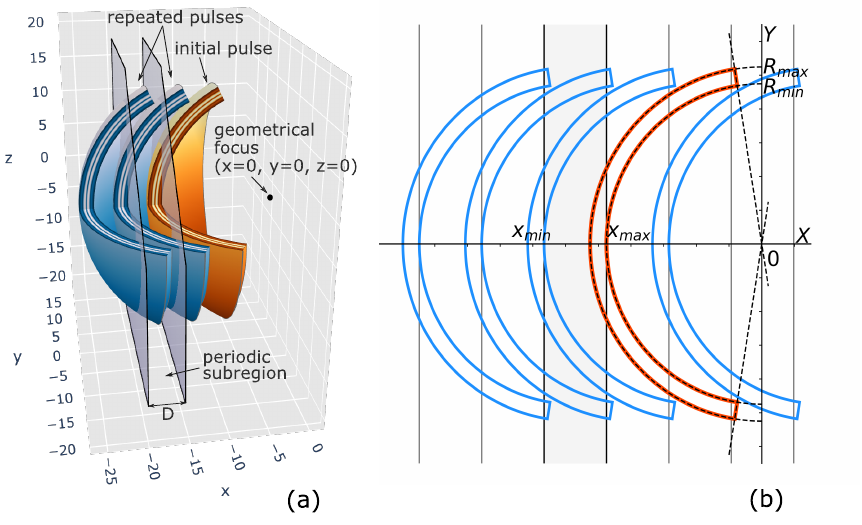
Figure 3. Schematic illustration of the proposed method in 3D space ( a ) and the cross-section in the x - y plane at z = 0 ( b ). The restriction given by Equation (12) is derived from requiring that the initial (red) and replicated (blue) pulses do not overlap. The shaded region is the subregion where the simulation is